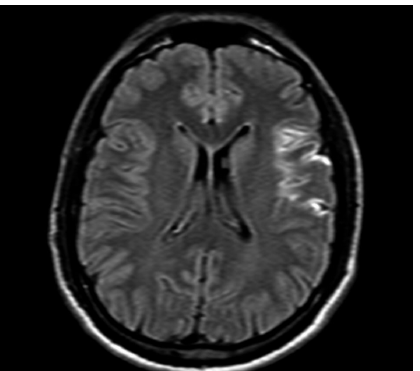
Transient Gerstmann syndrome as manifestation of stroke